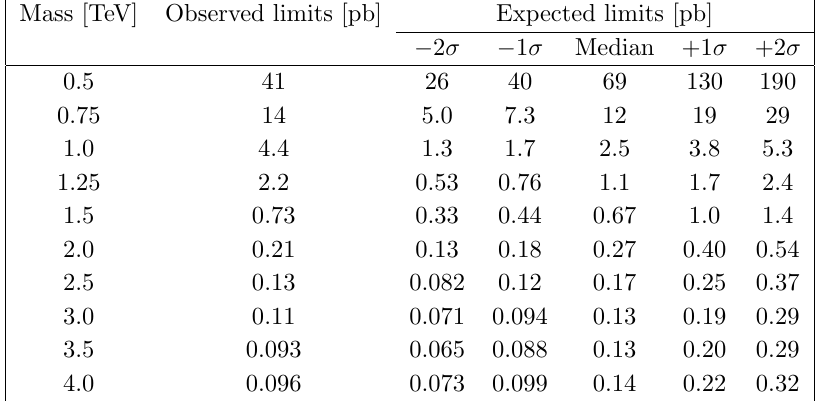
Table 9 . Expected and observed cross section limits at 95% CL, for the RS KK gluon hypothesis.